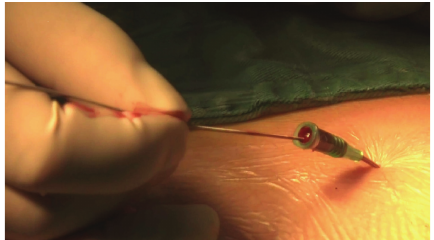
Figure 2: Extraction of the guide wire after insertion of a conveyor tube.